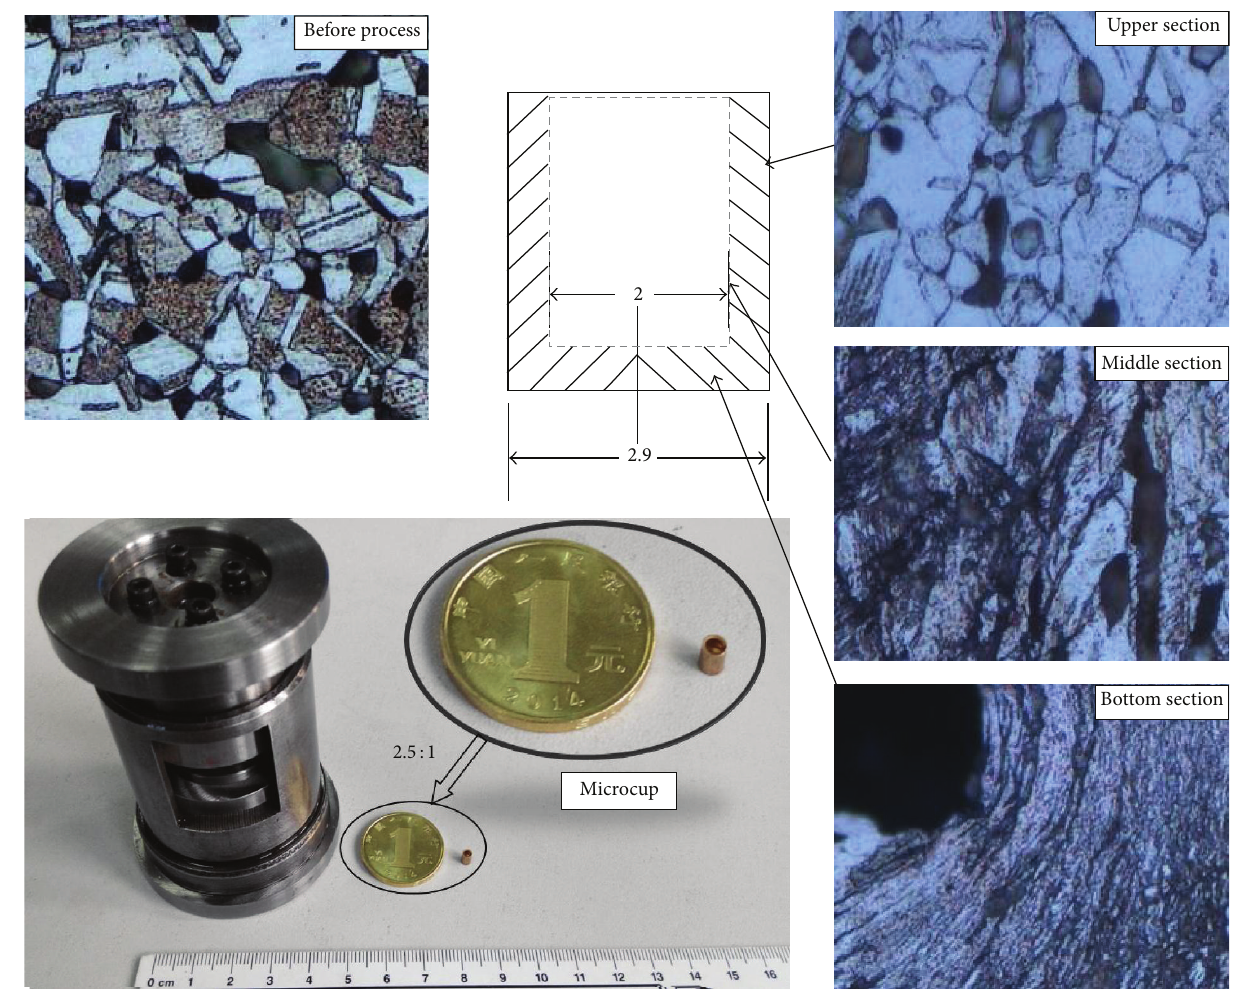
Figure 6: The micromold, the microcup, and the grain